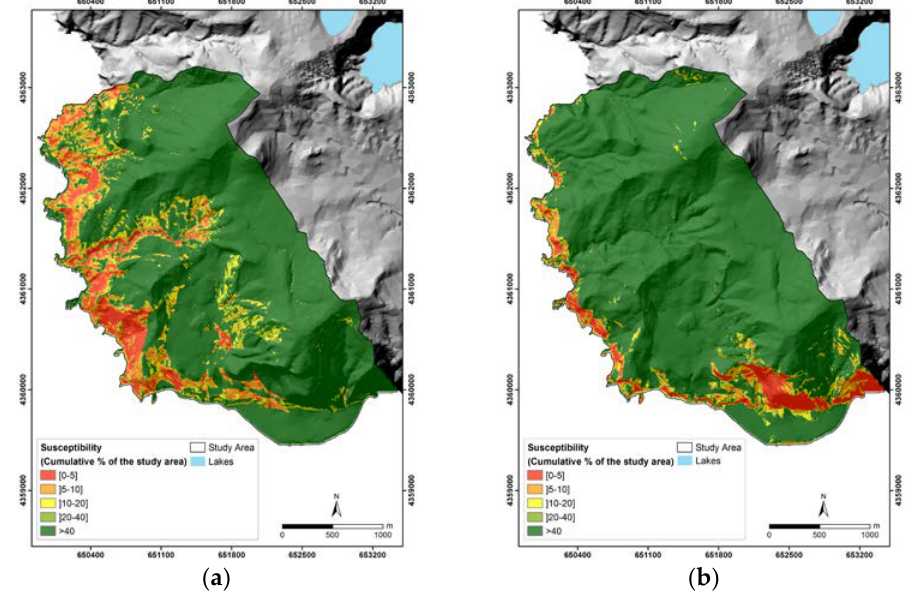
Figure 11. Final landslide susceptibility maps computed for: ( a ) falls and ( b ) slides.